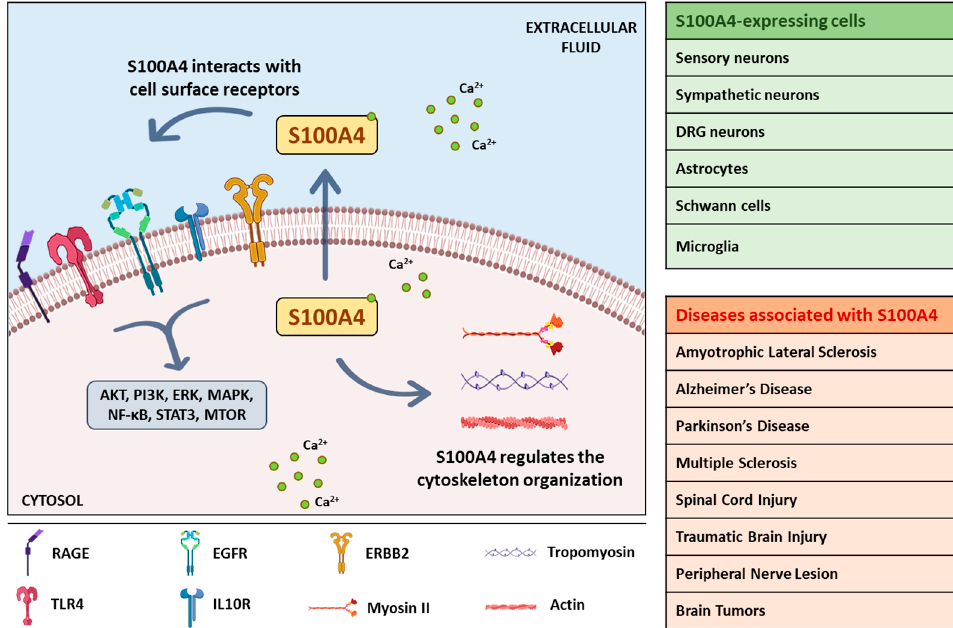
Figure 2. Schematic illustration of intracellular and extracellular actions of S100A4. Cytosolic S100A4 binds to calcium and interacts with cytoskeletal proteins; secreted S100A4 interacts with cell surface receptors leading to downstream signaling. Neuronal and non-neuronal cells expressing S100A4 and the nervous system pathologies involving S100A4 are shown in the box. AKT, protein kinase B; EGFR, epidermal growth factor receptor; ERBB2, Erb-B2 Receptor Tyrosine Kinase 2; ERK, extracellular signal-regulated kinase; IL10R, interleukin 10 receptor; MAPK, mitogen-activated protein kinase; MTOR, mammalian target of rapamycin; NF- κ B, nuclear factor- κ B; PI3K, phosphoinositide 3-kinases; RAGE, receptor for advanced glycation end products; STAT3, signal transducer and activator of transcription 3; TLR4, Toll Like Receptor